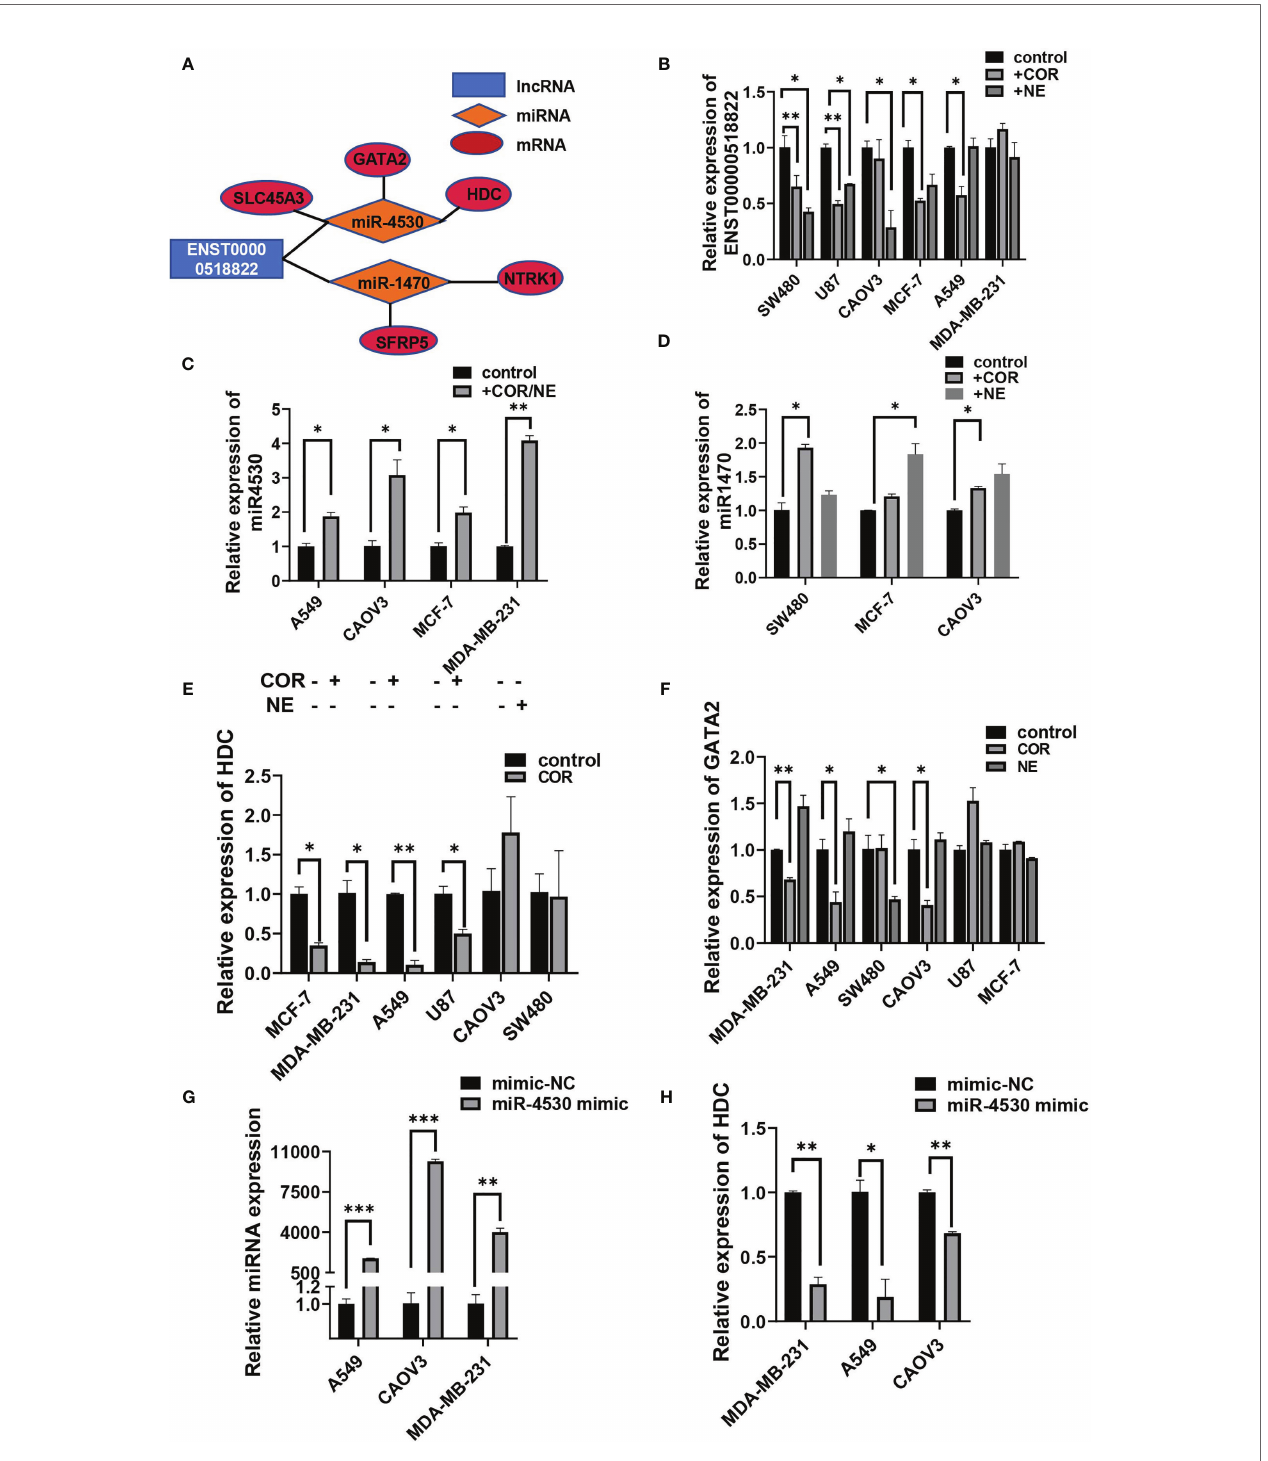
FIGURE 9 | Validation on regulatory relationship of cancer-associated ceRNA networks. (A) ceRNA network of some cancer-related genes. qRT-PCR analysis of the relative expression of ENST00000518822 (B) miR-4530 (C) and miR-1470 (D) , HDC (E) , and GATA2 (F) . miR-4530 (G) and HDC (H) in A549, CAOV3, and MDA- MB-231 cells by miR-4530 mimics. * p < 0.05, ** p < 0.01, *** p <